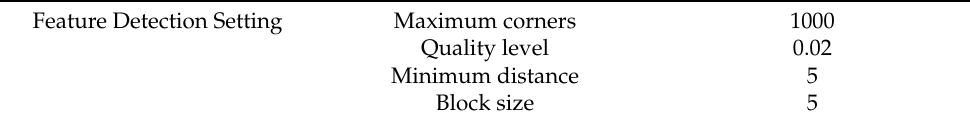
Table 1. Parameter settings for the Shi–Tomasi corner detection